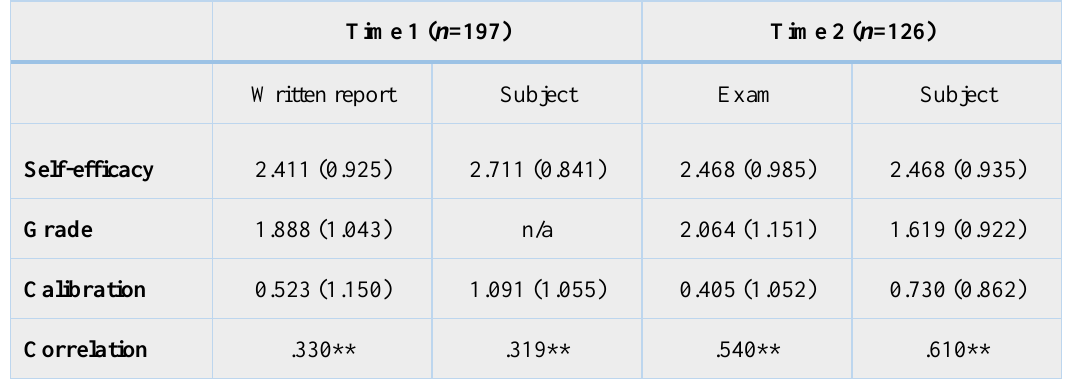
Means and standard deviations (in parentheses) for main study variables and correlations between self-efficacy and grades for each academic outcome